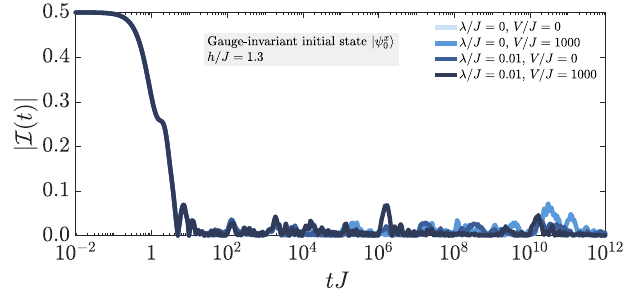
FIG. 3. Quench dynamics under ˆ H = ˆ H 0 + λ ˆ H 1 + V ˆ H W of the imbalance (7) starting in the gauge-invariant domain-wall (cid:3) ; see Fig. 2. As predicted by the corresponding thermal state | ψ x 0 ensembles, the system thermalizes with the imbalance vanishing regardless of what values λ and V